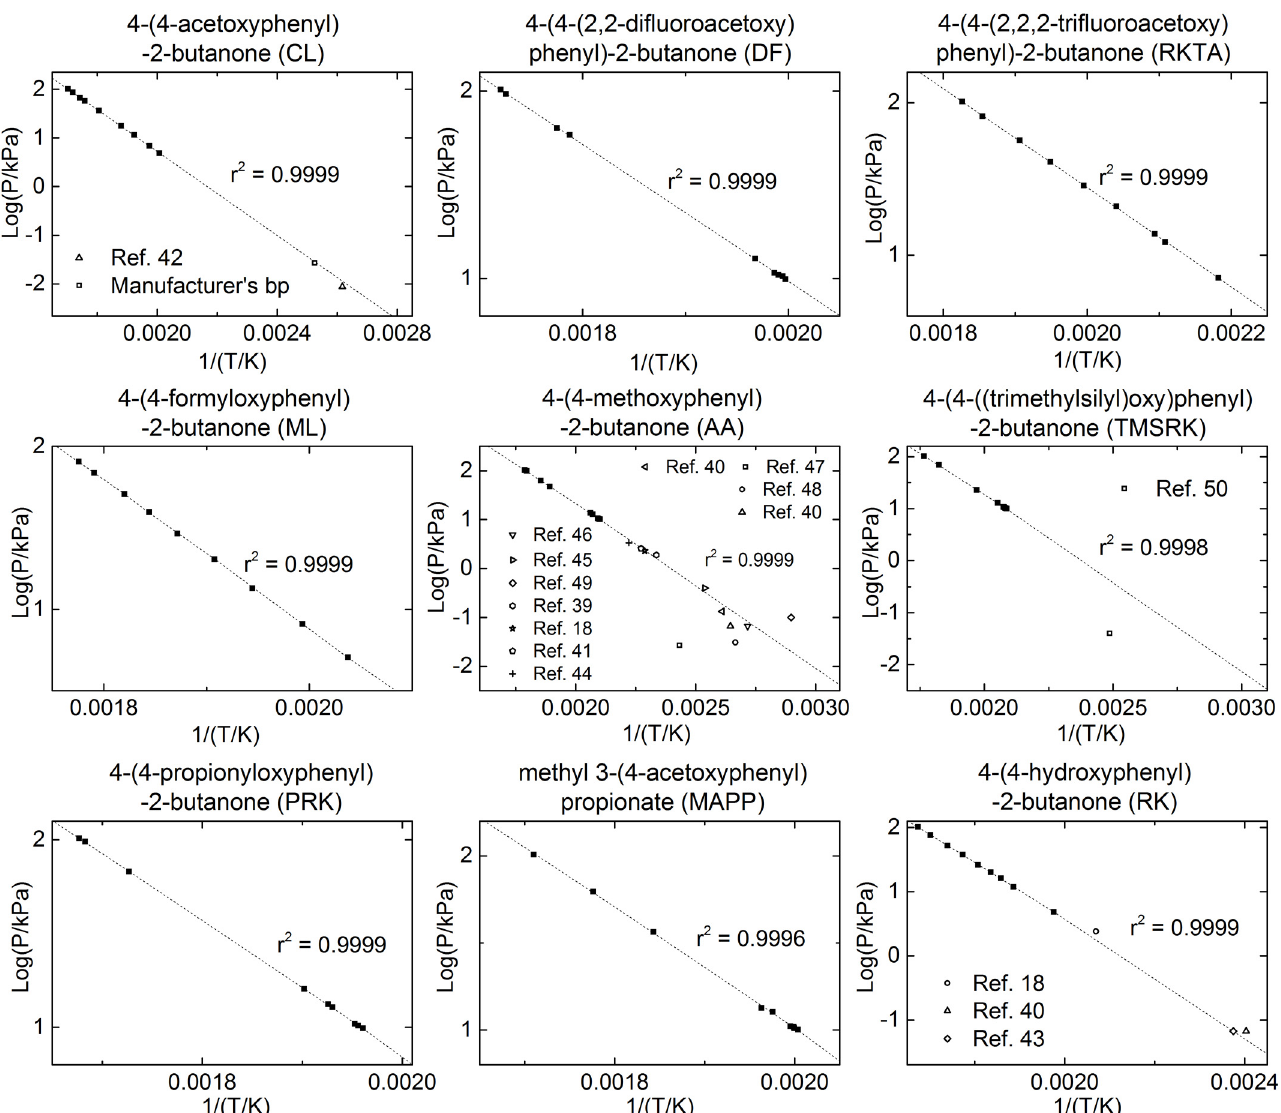
Fig 2. Vapour Pressure of Nine Compounds. ■ , data generated by DSC methodology in the present study; previously reported data were presented in each plot; -----, regression fit to the Antoine